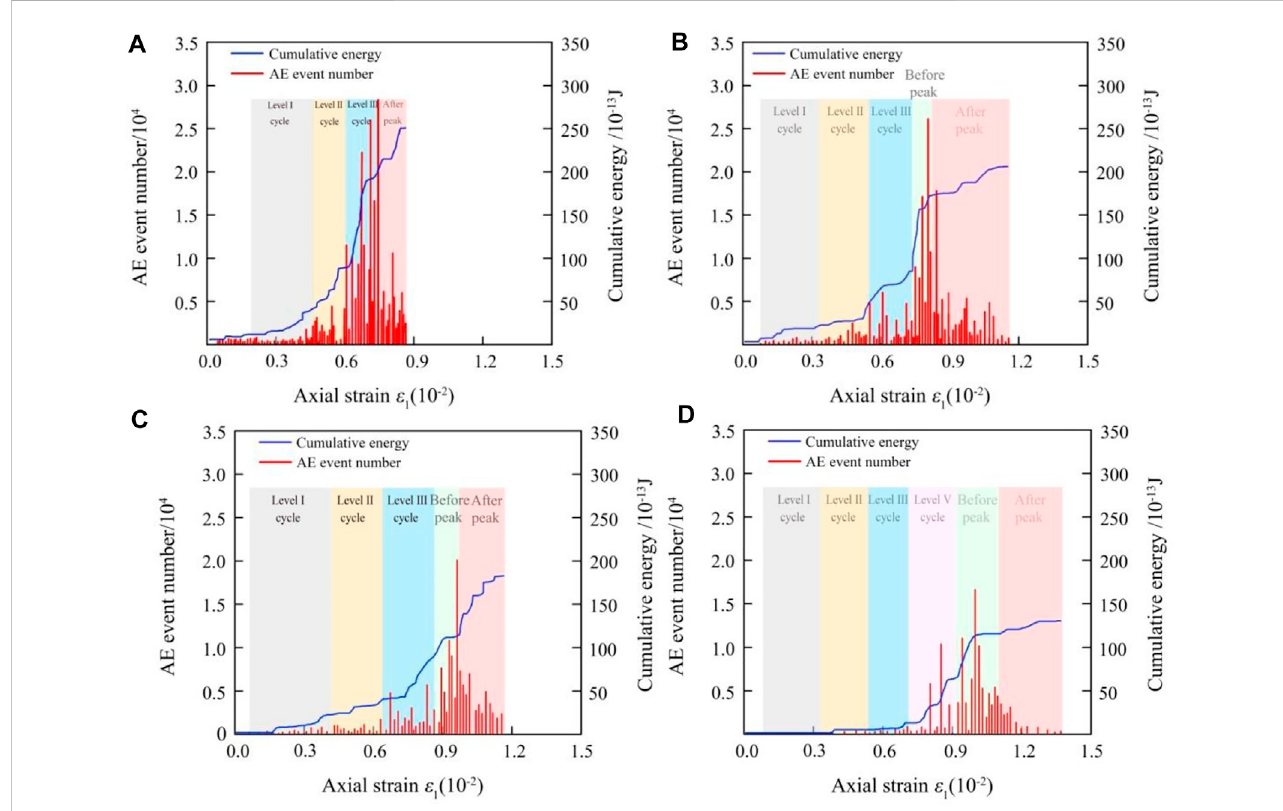
FIGURE 8 AE cumulative energy and AE event number of coal specimens with cyclic loading and unloading at different stress lower limits (A) under normal pressures, (B) under 3 MPa con fi ning pressure, (C) under 6 MPa con fi ning pressure, and (D) under 9 MPa con fi ning